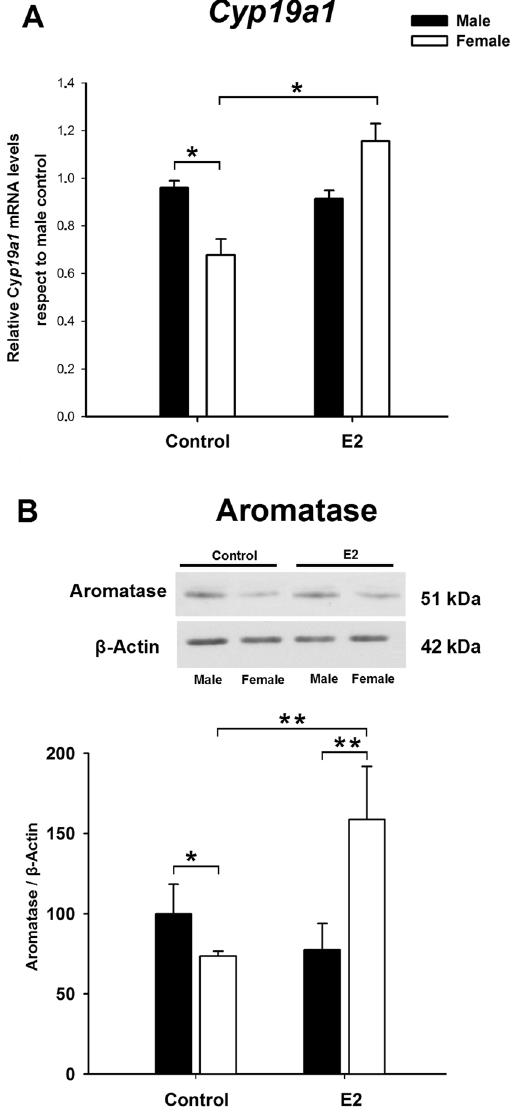
Figure 2. Effect of 17 β -oestradiol (E2) on aromatase mRNA ( Cyp19a1 , A) and protein (B) in male and female primary amygdala neuronal cultures from CD1 mouse embryos. E2 stimulation increased aromatase mRNA levels in female but not in male neuronal cultures. * p ≤ 0.05 vs. male and female + E2. Bars indicate mean + SEM. n = 4–6 independent